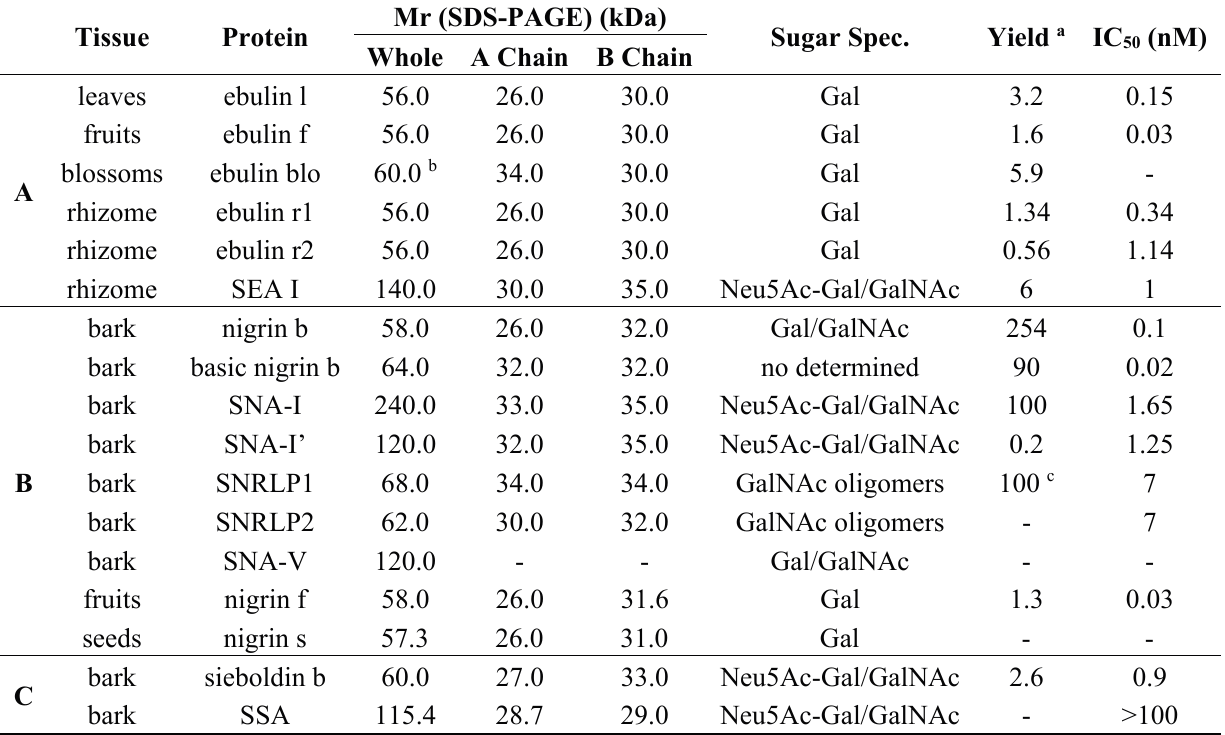
Table 1. Type 2 RIPs from Sambucus